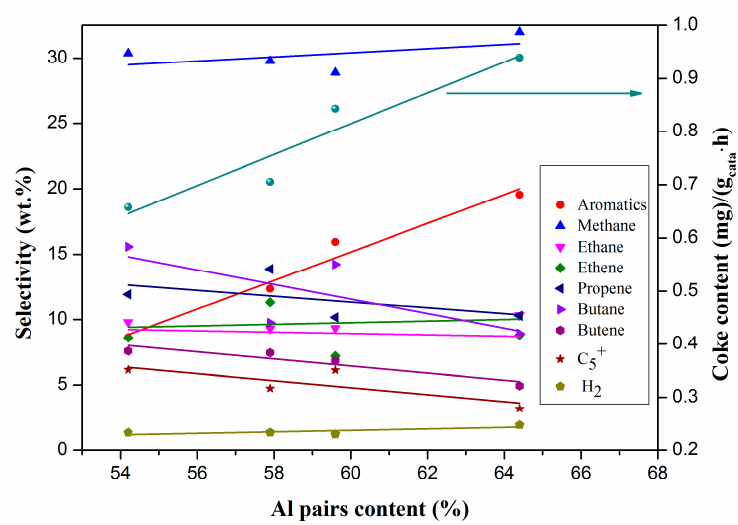
Figure 6. Product selectivity in propane aromatization at 20 h (TOS) and coke content in the used catalysts as a function of Al F pairs content in the framework of HZSM-5 catalysts.